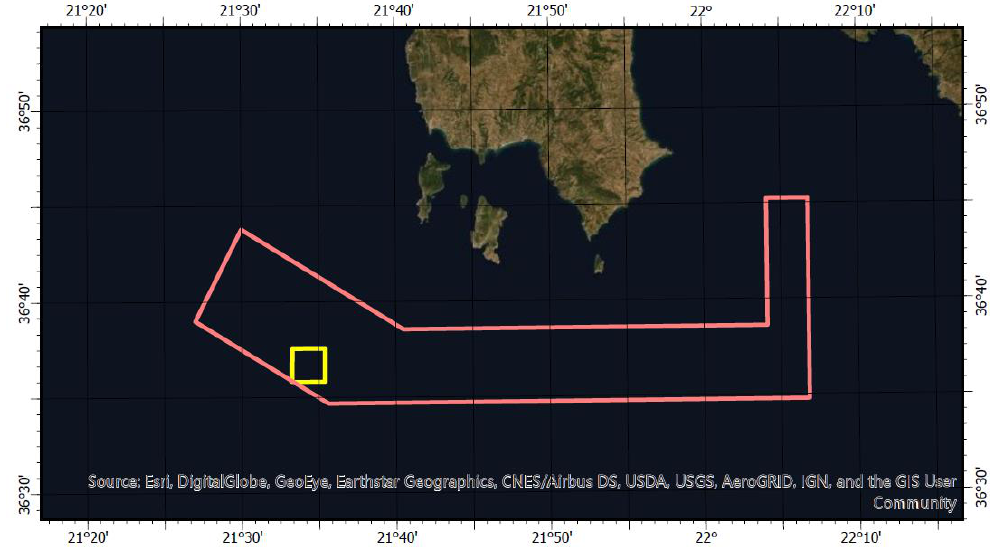
Figure 4. The boundary of the 500 km 2 competition area (red color) with the obligatory deep water 10 km 2 part marked in